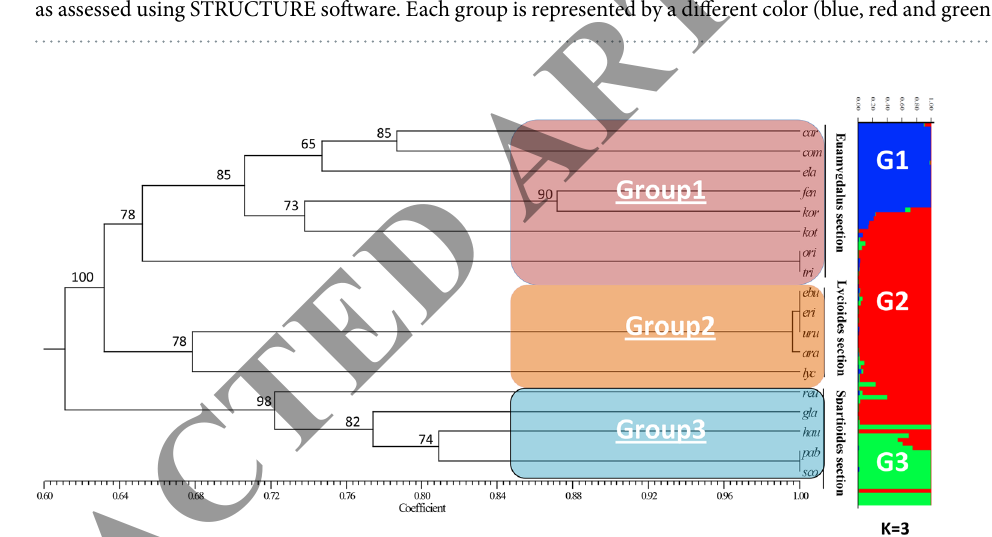
Figure 2. Dendrogram obtained with the similarity simple matching (SM) coefficient pair group method with the arithmetical average clustering algorithm from 587 REAMP markers for 389 wild almond species. The value on the dendrogram gives the stability of nodes estimated with a bootstrap procedure (no number indicates support less than 10%). Bar graphs showing genetic diversity structure for the 389accessions of Prunus species as assessed using STRUCTURE software. Each group is represented by a different color (blue, red and green).